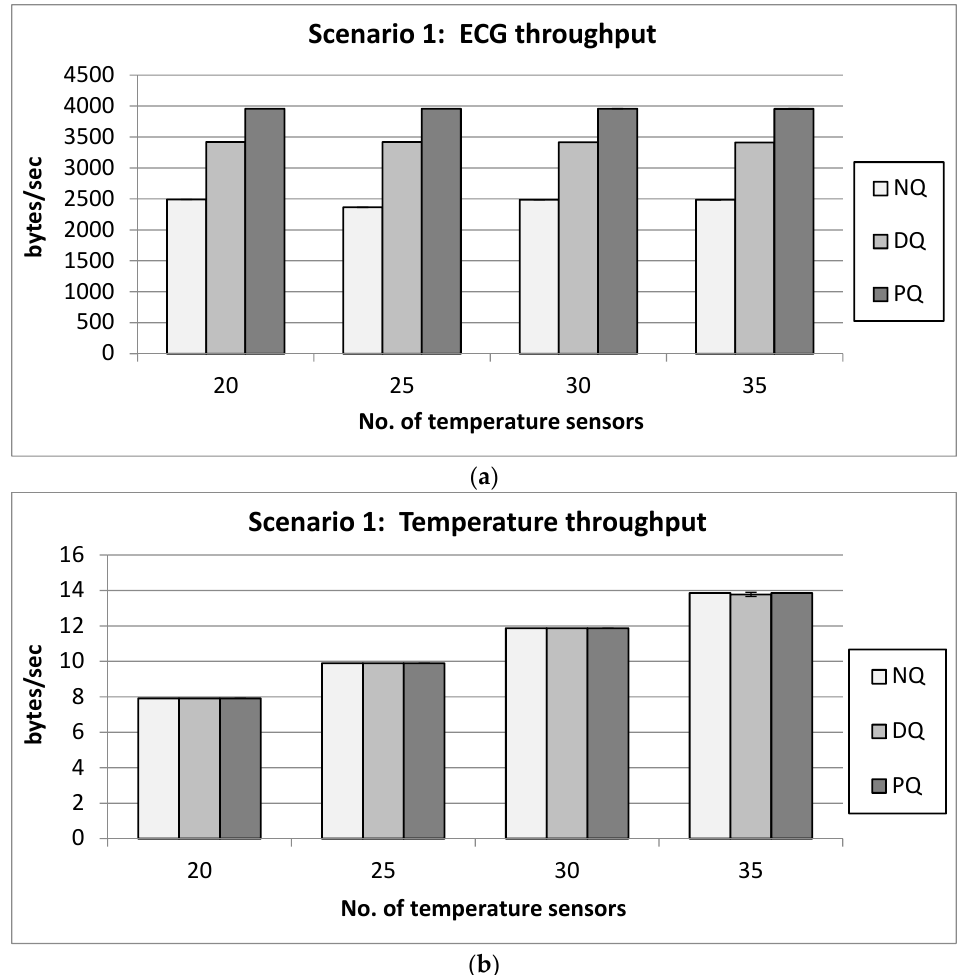
Figure 7. Average throughput results comparison for various data traffic types.